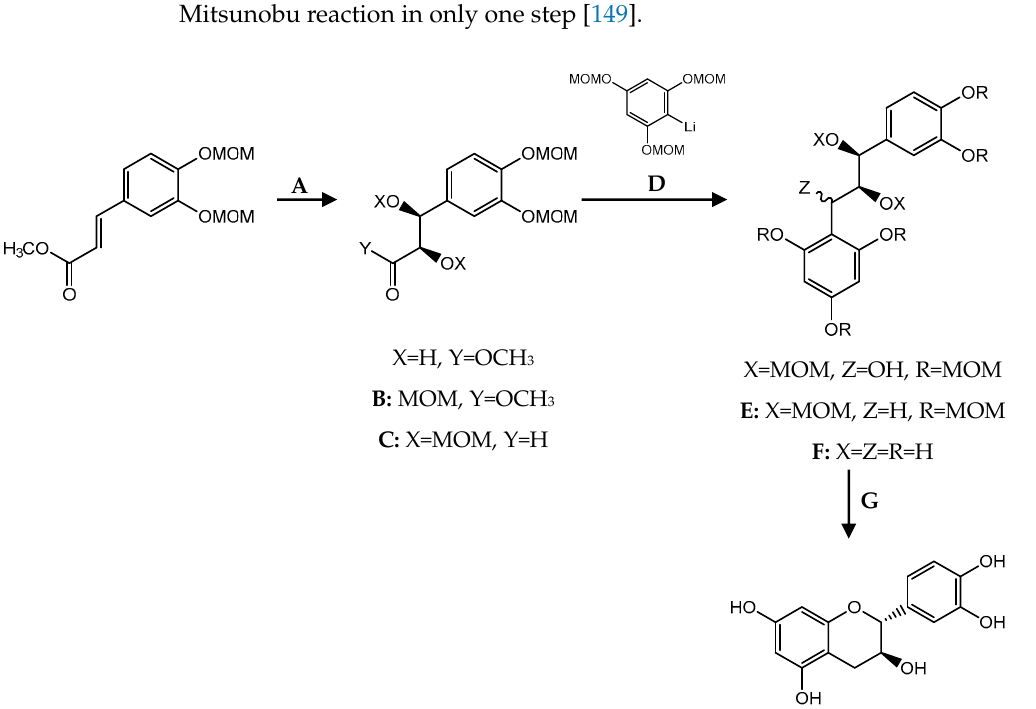
Figure 19. Cyclization by intramolecular Mitsunobu reaction. ( A ) AD-mix α , MeSO 2 NH 2 , t BuOH, H 2 O, 100%; ( B ) MOMCl, i -Pr 2 NET, CH 2 Cl 2 , 89%; ( C ) DIBAL-H, PhMe, − 78 ° C, 87%; ( D ) n -BuLi, THF, − 78 ° C, 53%; ( E ) (i) NaH, imidazole, CS 2 , CH 3 I, THF, 99%, (ii) n -Bu 3 SnH, AIBN, benzene, 80 ° C, 91%; ( F ) 2% HCl, MeOH, 50 ° C, 49%; ( G ) PPh 3 , DEAD, THF, 50%.